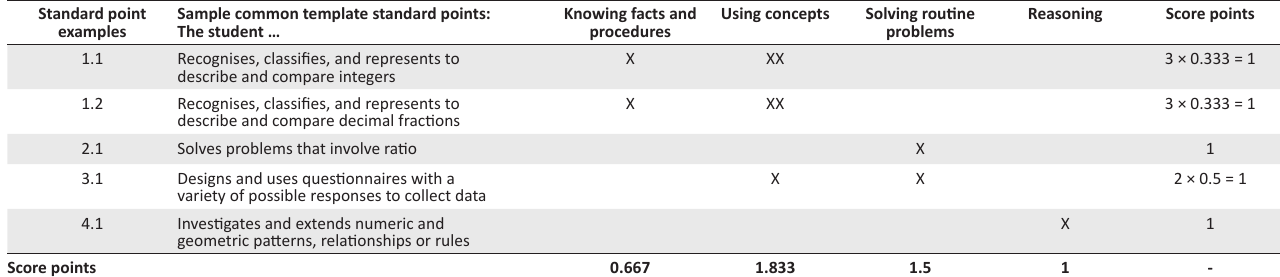
TABLE 2: Coding of the RNCS assessment standards according to TIMSS 2003 cognitive levels. Standard point